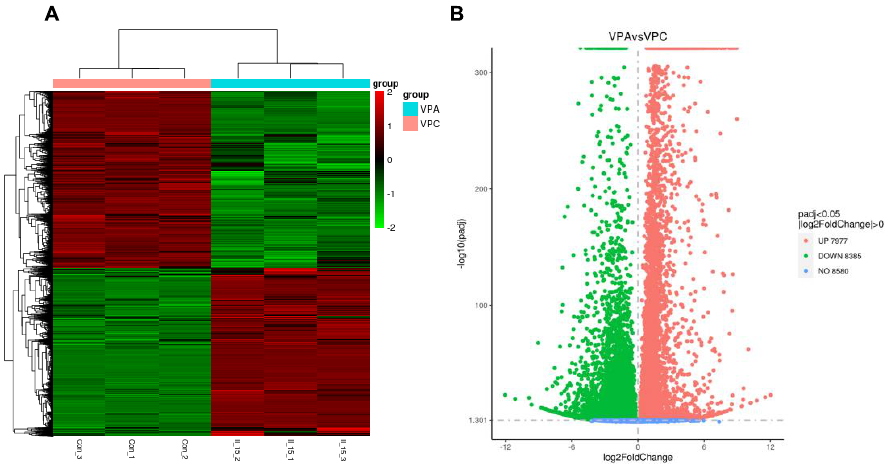
Figure 9. RNA sequencing analysis of A. thaliana treated by APD-II-15 . ( A ) Heatmap of differential expression genes; ( B ) volcano plot of differential expression genes.